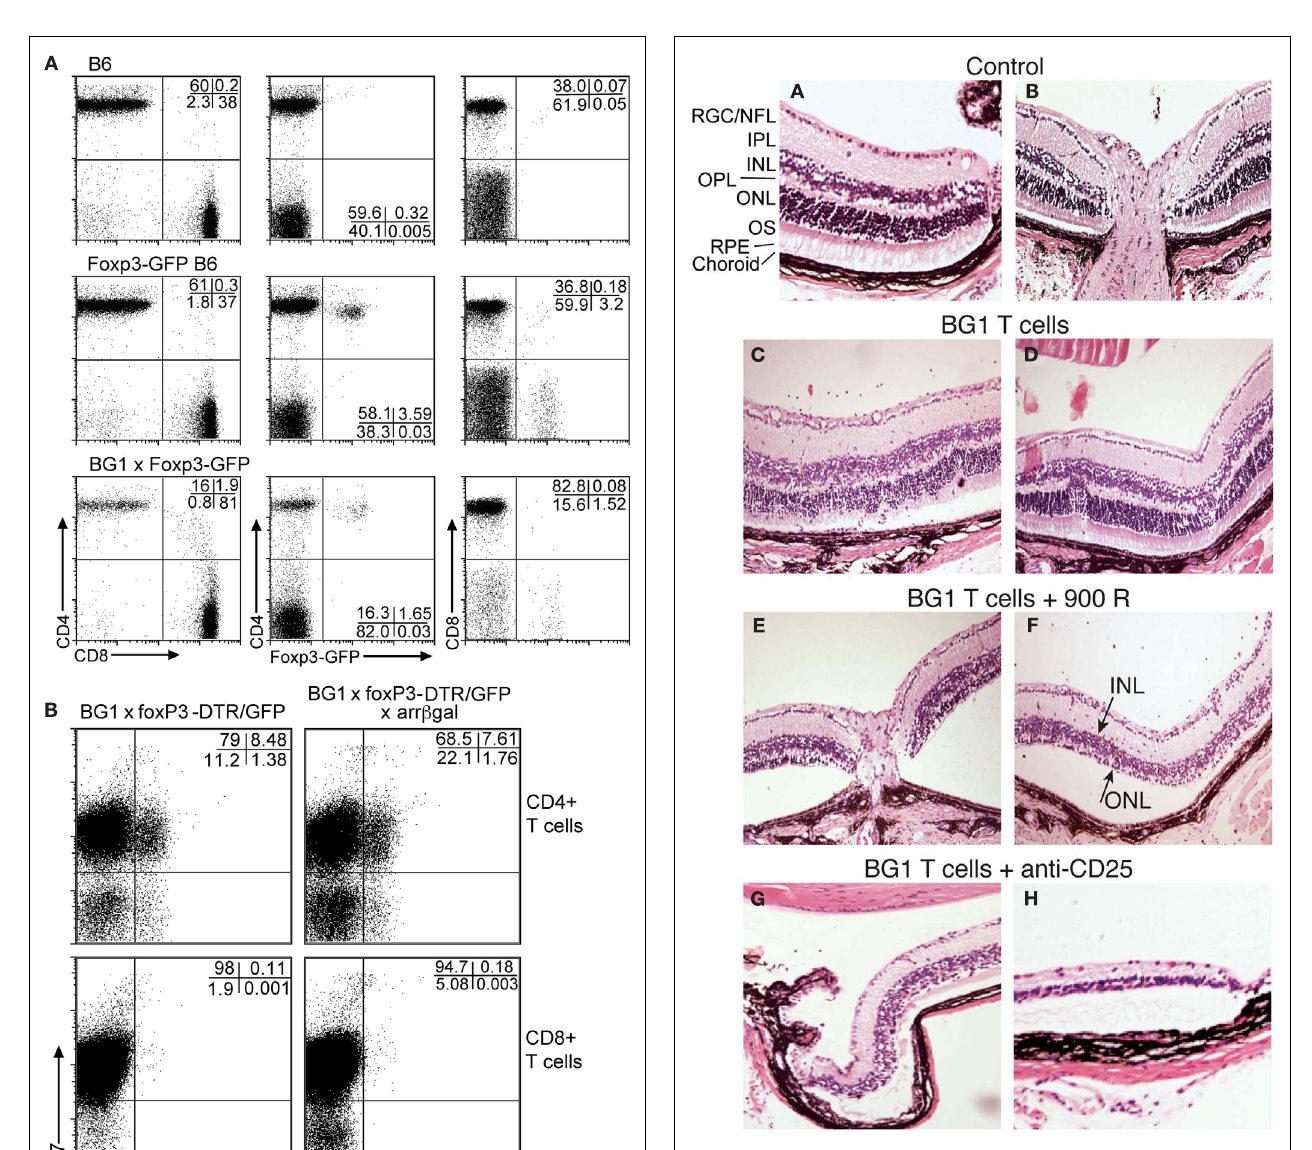
BG1 × Foxp3-DTR/GFP double Tg mice. Tregs were substan- tially depleted by the i.p. administration of DTx. One day later, DTH was assayed by the ear swelling response to β gal. Depleted BG1 × Foxp3-DTR/GFP double Tg mice had elevated levels of